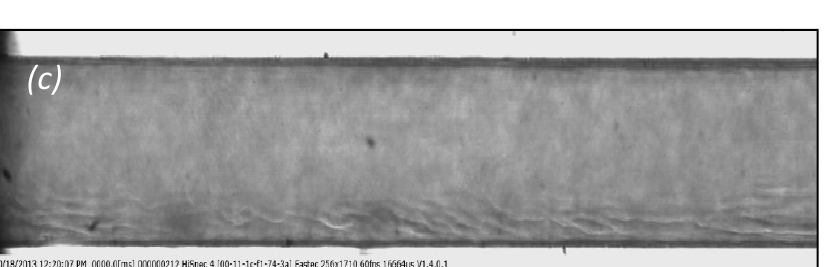
Figure 6. Typical images: ( a ) at the bottom of the micro-channel, ( b ) in the middle, and ( c ) at the top of the channel. ( D = 170 μ m, H c t = 10%, Q = 0.01 mL/h).